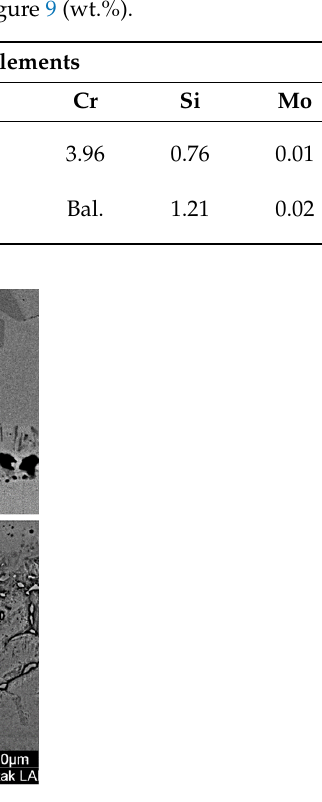
Figure 10. The microstructure of diffusion-affected zone on the side of: ( a ) super-ferritic stainless steel 446 an ( b ) martensitic stainless steel 410. The EDS analysis of dark masses in Figure 11a reveals that they are rich in iron, chromium, and niobium, with minor levels of nickel. These precipitations have signifi- cantly dedicated the secondary phase in the diffusion-affected zone. Due to the consid- erable quantity of chromium in this alloy, it was predicted that the needle phases on the side of super-ferritic stainless steel 446 would be rich in chromium (Figure 11b). The condition is different, and most of the secondary phases develop discontinuously at the